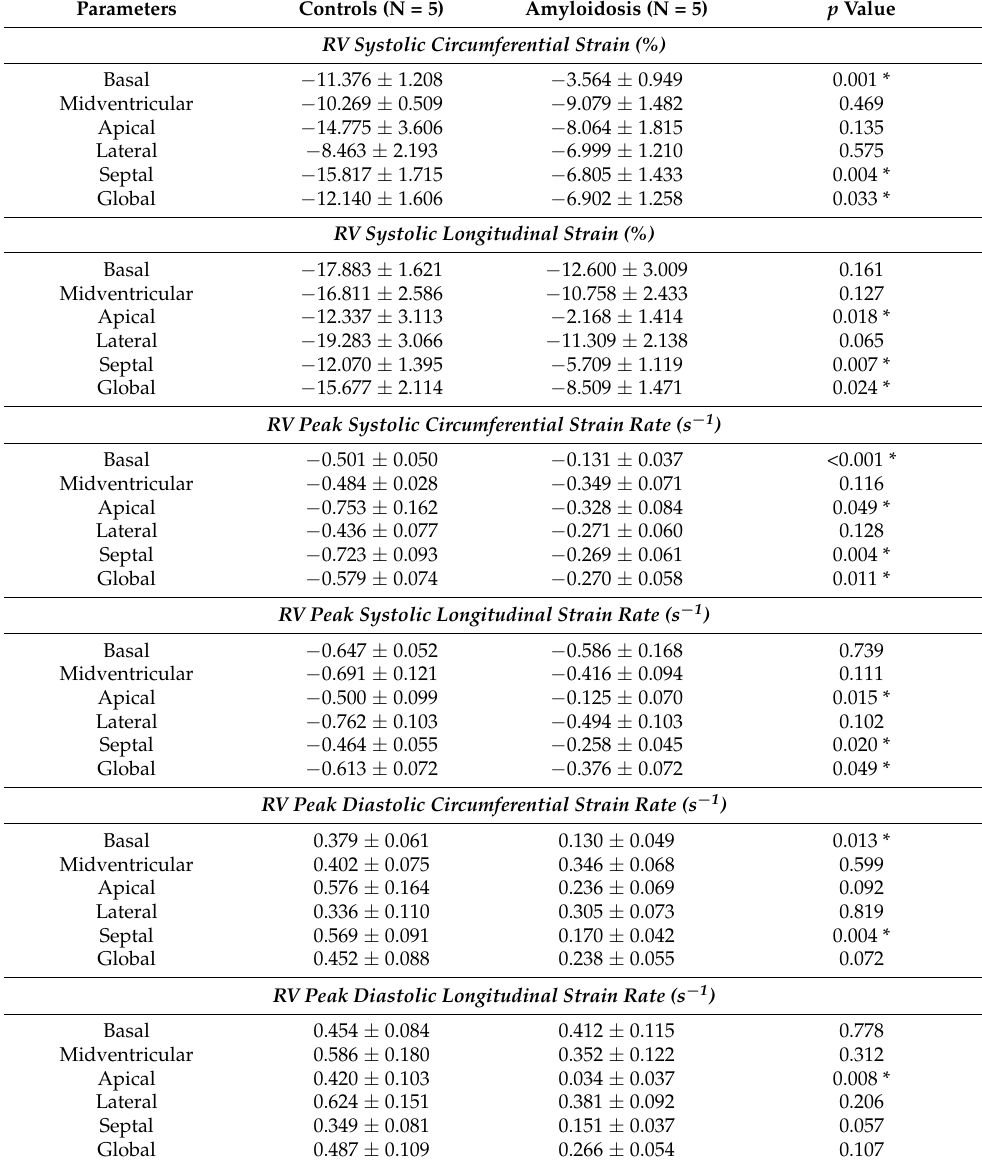
Table 3. Right ventricular (RV) strain and strain rate characteristics of amyloidosis patients compared to controls using cardiac